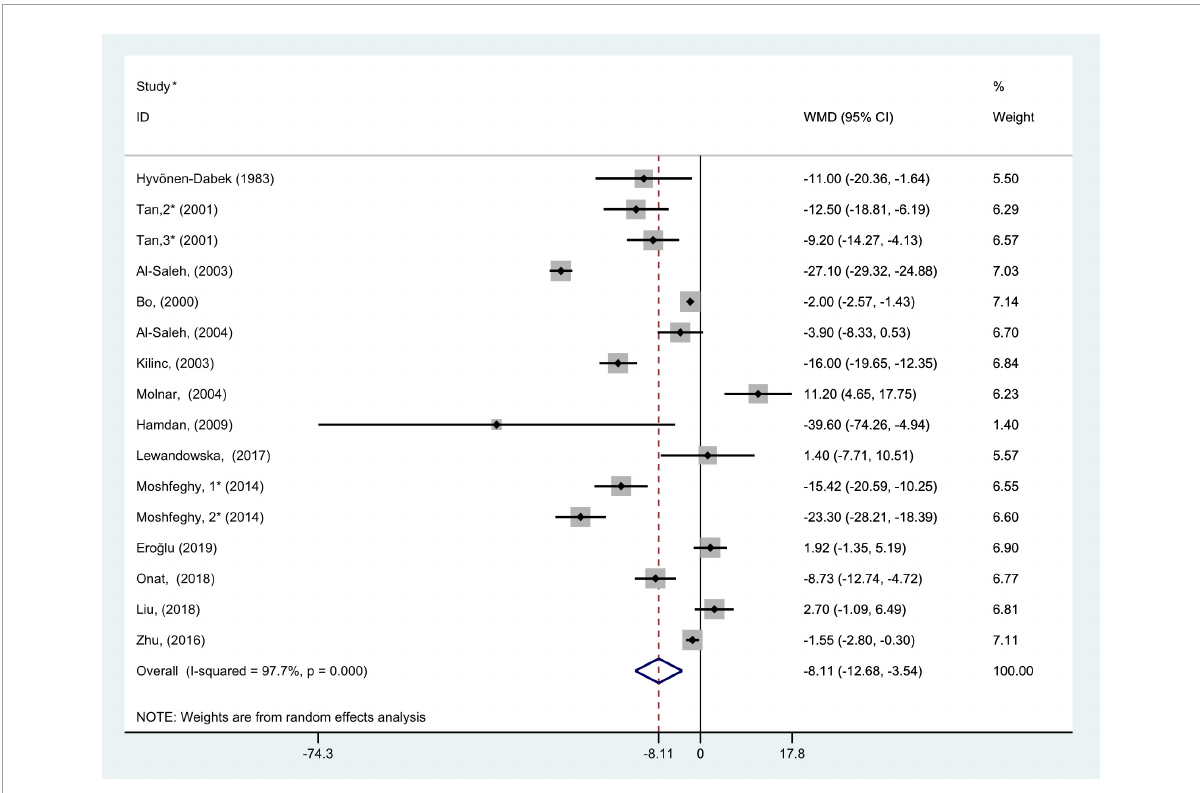
FIGURE2 Forest plot of the blood selenium level in patients with gestational diabetes mellitus and healthy pregnant women. The random effects model is applied. For studies in which blood selenium levels were measured during different pregnancy periods in one study, 1, 2, and 3 are used to denote measurements performed in the first, second, and third trimesters, respectively. *First author (year of study completion).